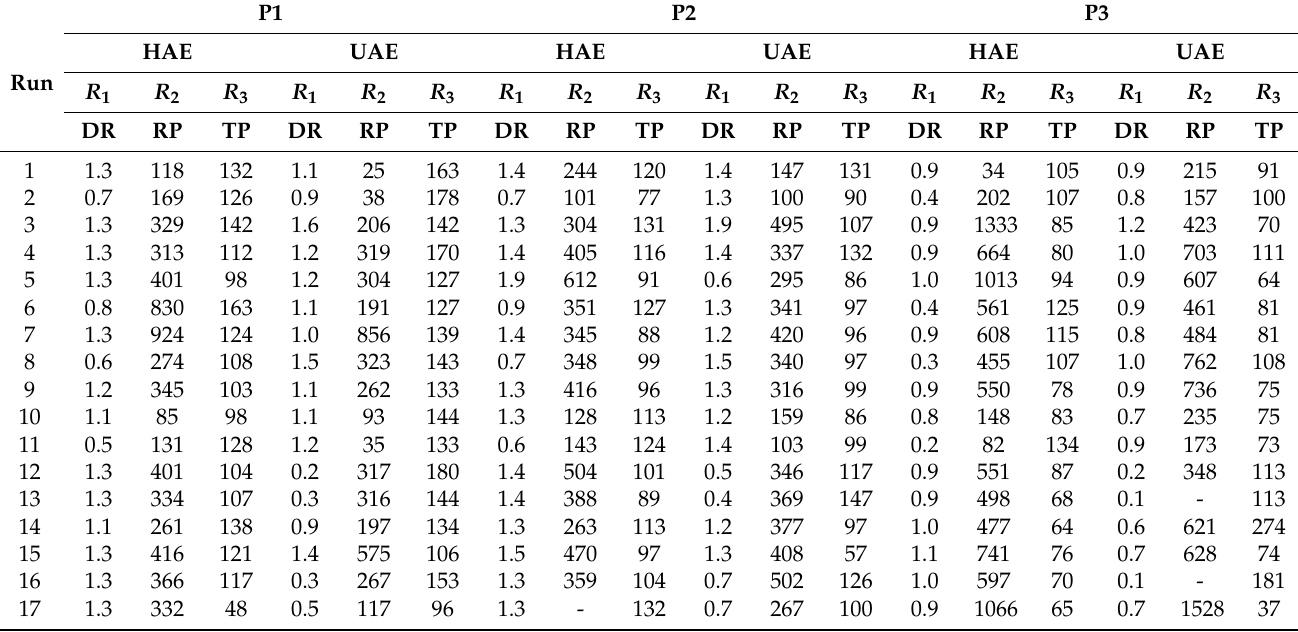
Table 2. Results of the extraction runs of the independent variables of time, temperature/power, and ethanol percentage in the solvent for the two extraction techniques applied (heat-assisted extraction: HAE; and ultrasound-assisted extraction: UAE) and for the three dependent variables evaluated ( R 1 , g/100g; R 2 , µ g/mL; and R 3 ,